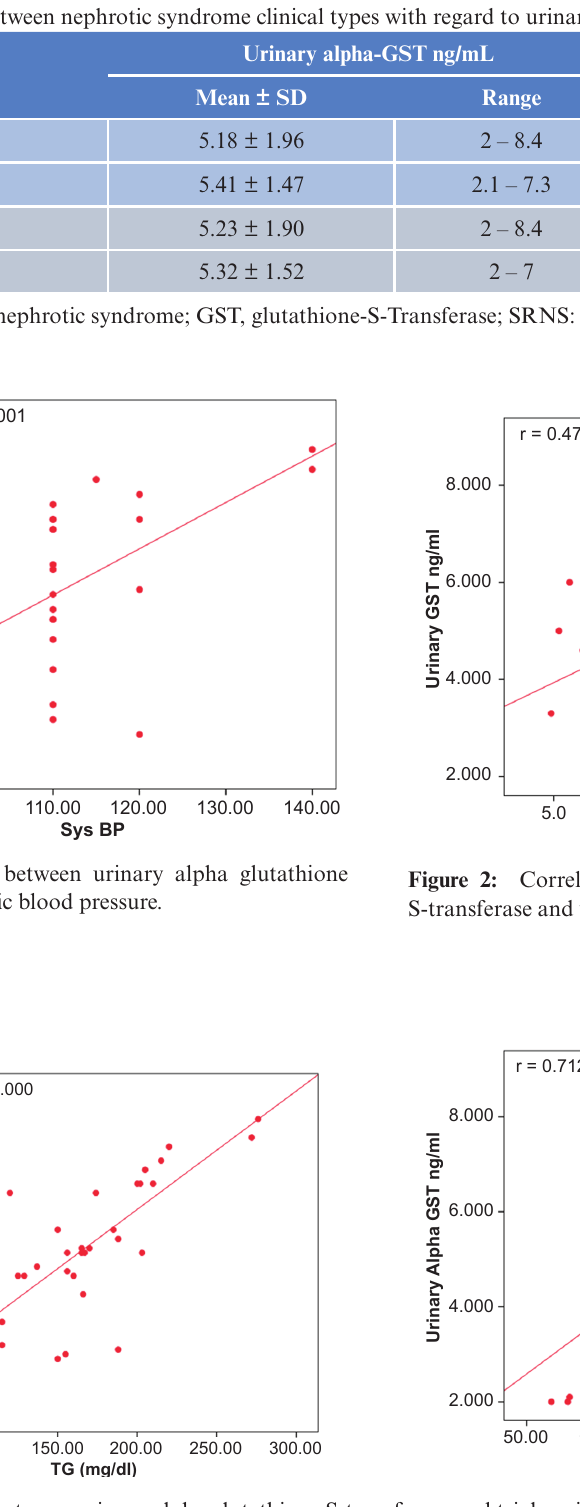
Figure 3: Correlation between urinary alpha glutathione S-transferase and triglyceride serum